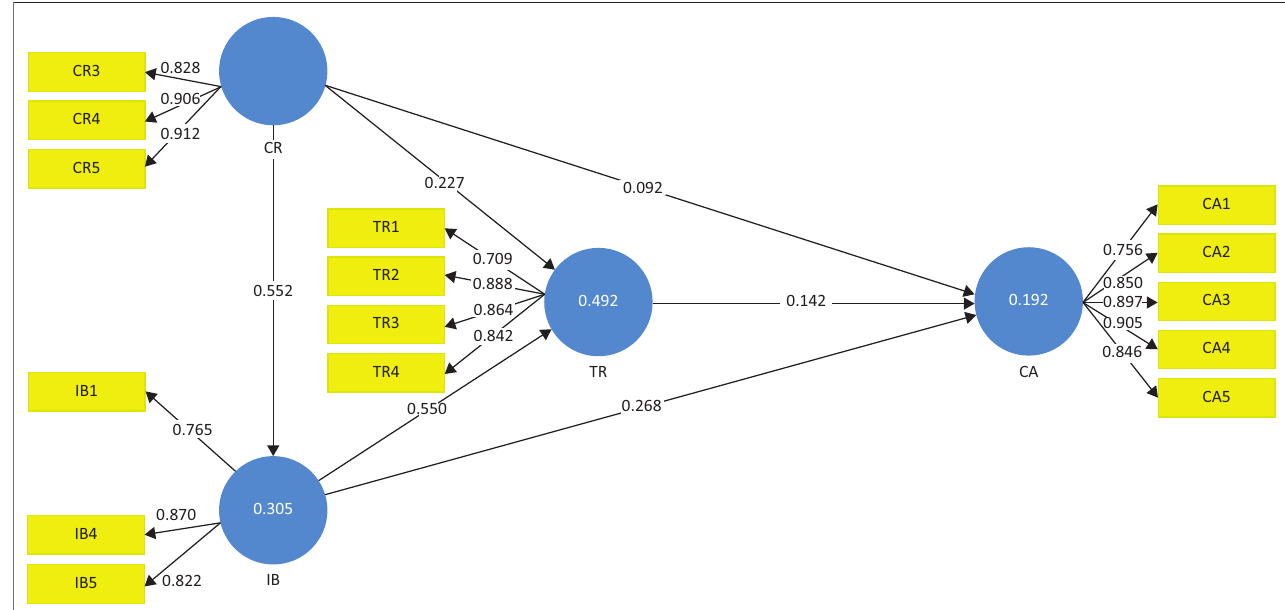
FIGURE 2: Full model of research